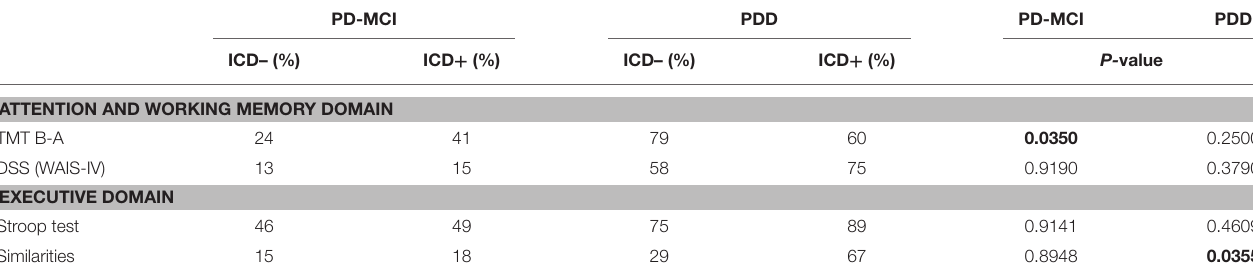
TABLE 4 | Percentage of ICD + and ICD– across cognitive states with a cognitive performance below 1.5 SD, in the attentive and executive